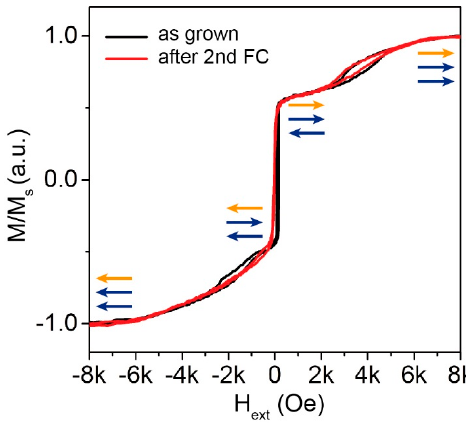
Figure 4. Magnetization as a function of the external magnetic field measured along the easy-axis of the bottom pinned layer on an as-grown sample (black line) and after the second field cooling (red line).